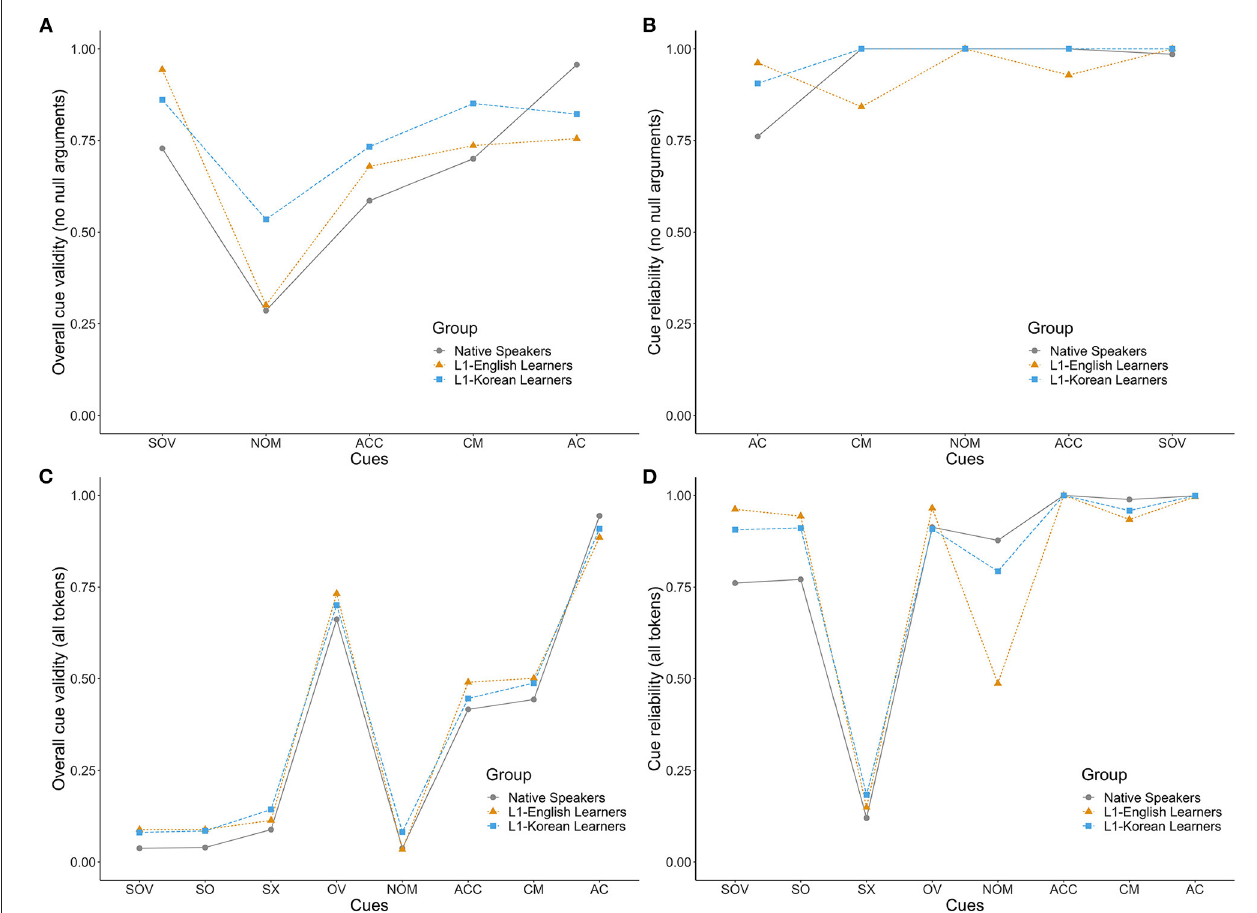
FIGURE 3 | Overall validity and reliability of cues (SOV, canonical word order; SO, subject-object; SX, subject-first; OV, preverbal object; NOM, nominative; ACC, accusative; CM, case marking, combined; AC, animacy) in sentences with an overt subject and object [ (A,B) , respectively] and in all sentences [ (C,D) , respectively].